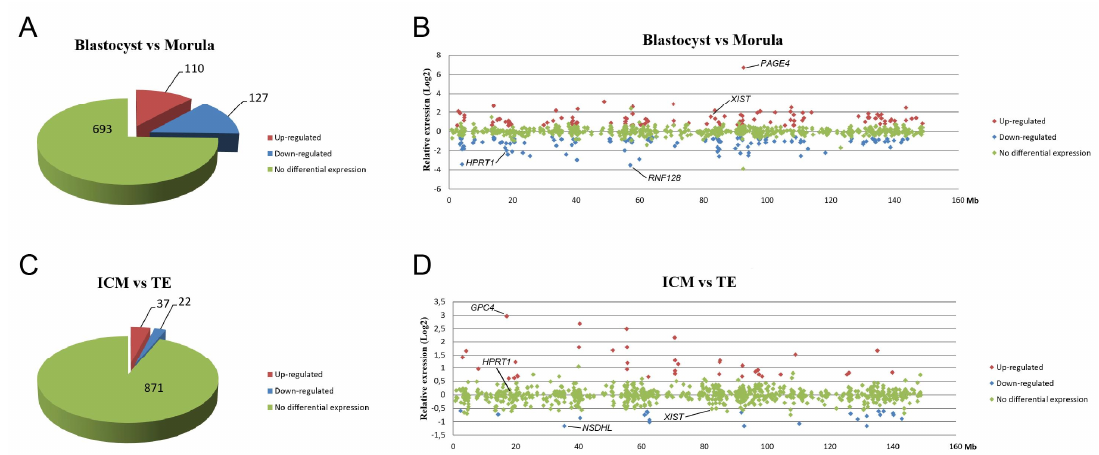
Figure 6. Proportional distribution of X-linked gene expression in blastocysts versus morulae and inner cell mass cells versus trophectoderm cells. Proportional distribution of upregulated (red), downregulated (blue), and equally expressed (green) X-linked genes in blastocysts versus morulae ( A ) and inner cell mass cells versus trophectoderm cells ( C ). The relative expression (Log2) of X-linked genes in blastocysts versus morulae ( B ) and inner cell mass cells versus trophectoderm cells ( D ) are plotted according to their locations on the X chromosome.